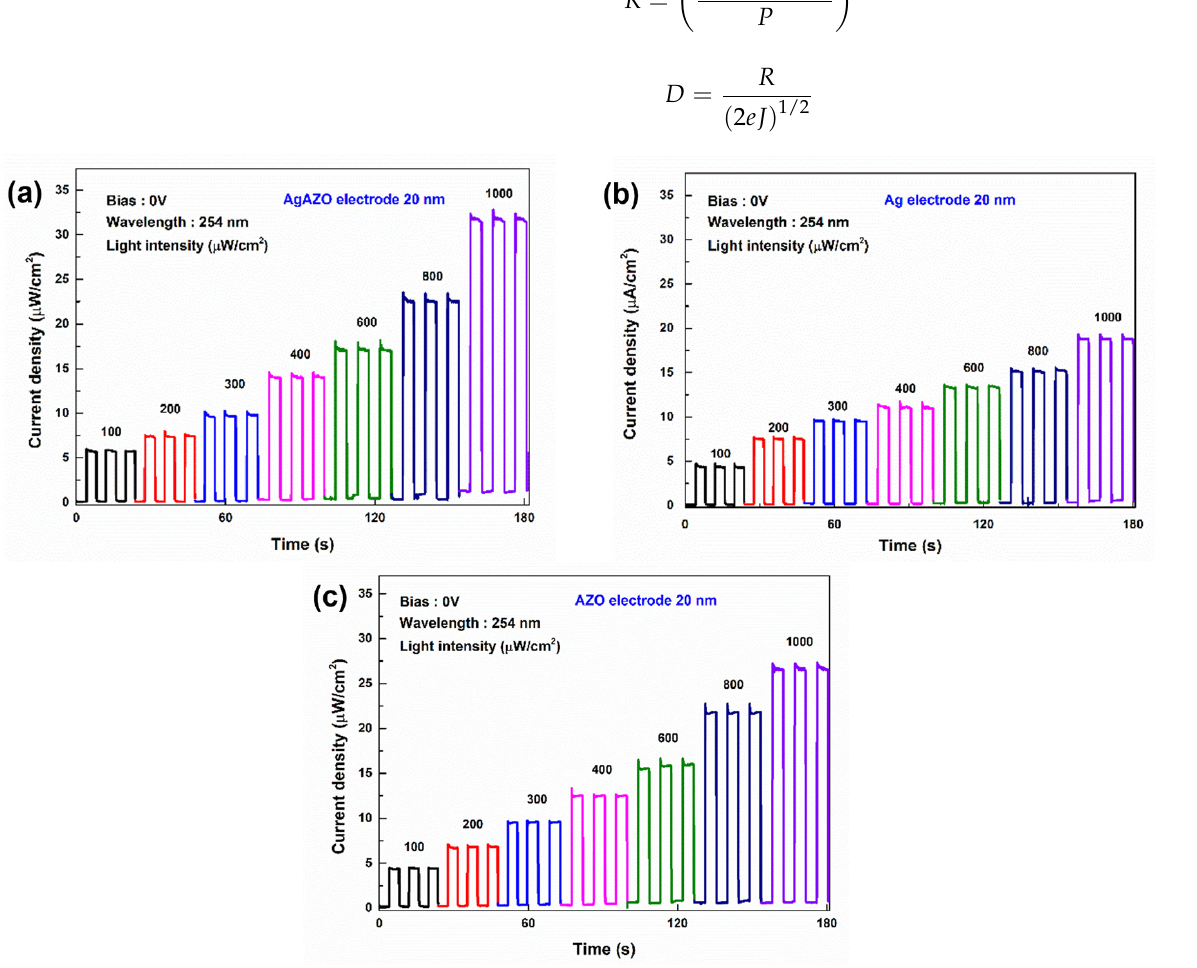
Figure 11. Photocurrent density change of device according to light intensity. ( a ) Ag:AZO 20 nm; ( b ) Ag 20 nm; ( c ) AZO 20